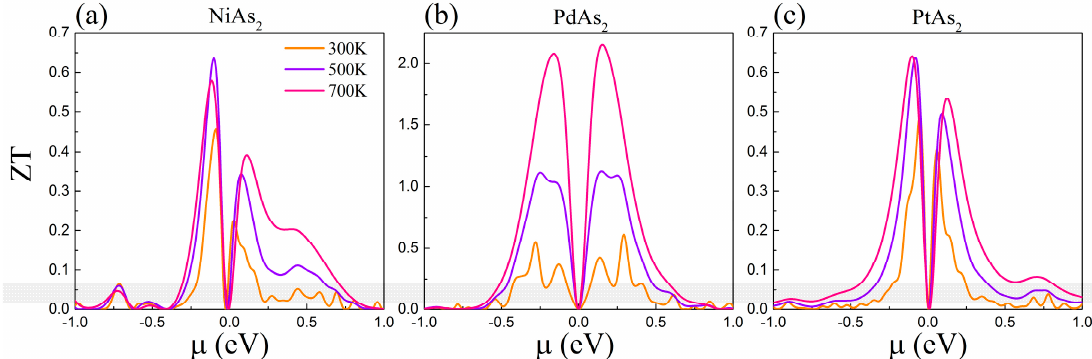
Figure 7. Thermoelectric figure of merit (ZT) value of monolayer ( a ) NiAs 2 , ( b ) PdAs 2 and ( c ) PtAs 2 as a function of chemical potential at 300, 500 and 700 K.